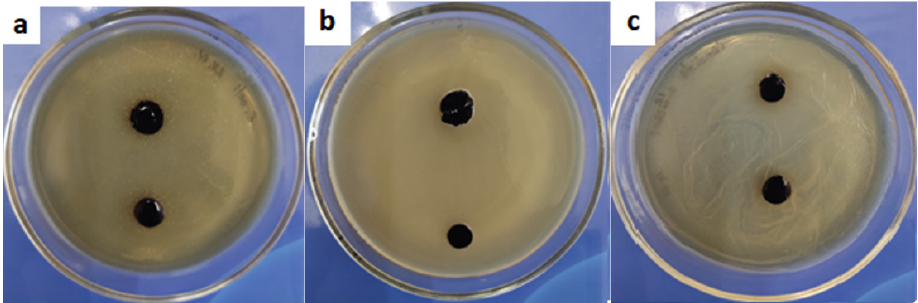
Figure 8. The state of the hydrogel 72 h after the antibacterial test with ( a ) Escherichia coli , ( b ) Staphylococcus aureus , and ( c ) Candida albicans .